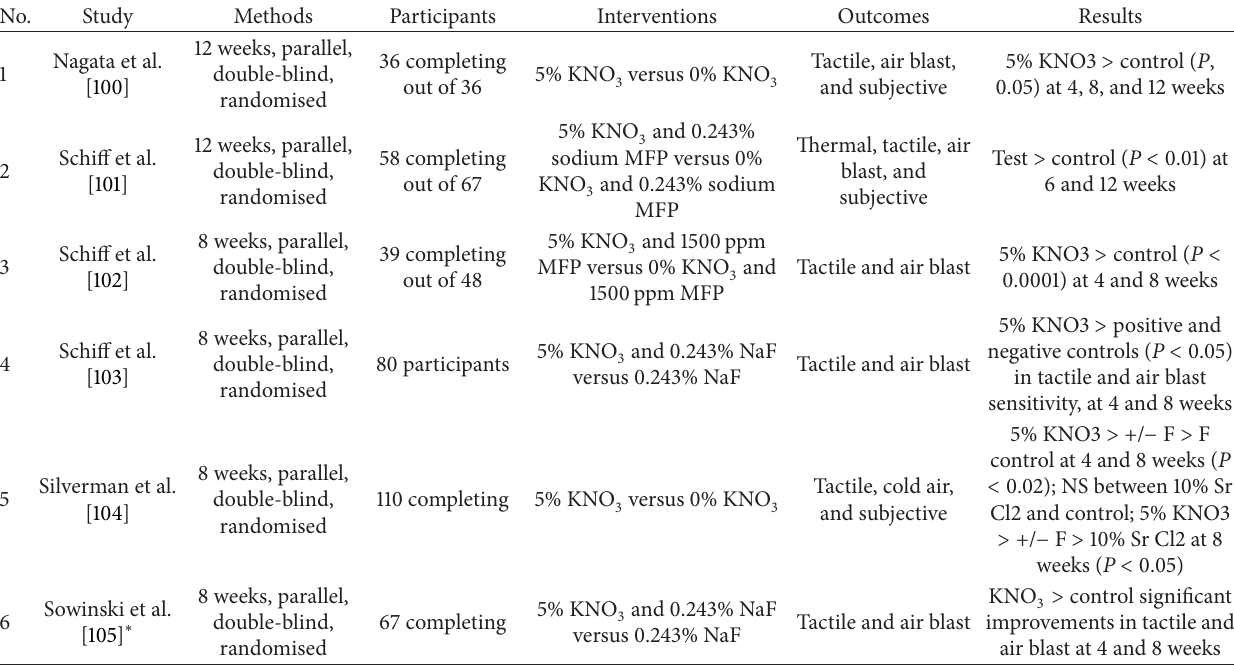
Table 4: Characteristics of Potassium containing toothpastes included studies.